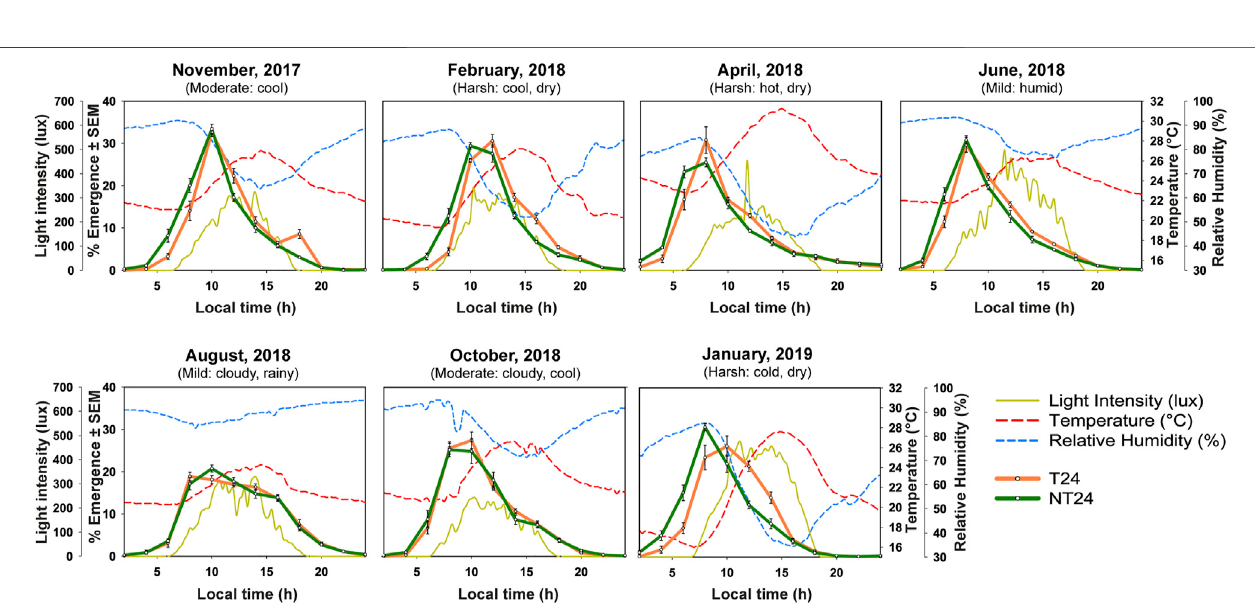
FIGURE 3 | Eclosion rhythm under changing semi-natural conditions (Nov-2017 to Jan-2019). Eclosion pro fi les for NT24 (green) and T24 (orange) plotted as daily numbers of emerging fl ies, averaged across 10 replicate vials, for assays conducted across various months of the year with weather description based on existing knowledge of fl y preferences. Assays were conducted in 7 different months from 2017 to 2019 under semi-natural conditions and average pro fi les for environmental variables of light (yellow-solid curve), temperature (red-dashed curve) and humidity (blue-dashed curve).